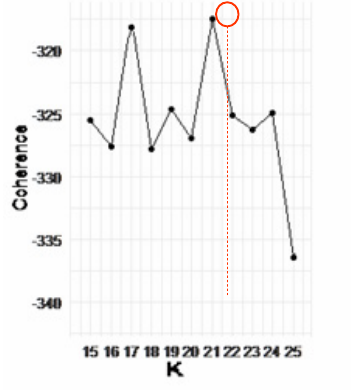
Figure 1. Perplexity index graph. The trend line is in blue. Acceptable k-interval is highlighted in red, where the trend line bends.